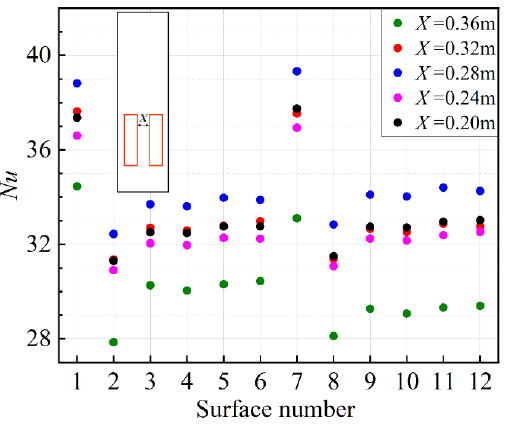
Figure 6. The distributions of average Nusselt number of all the surfaces of the heat sources with different horizontal distance X . different horizontal distance X